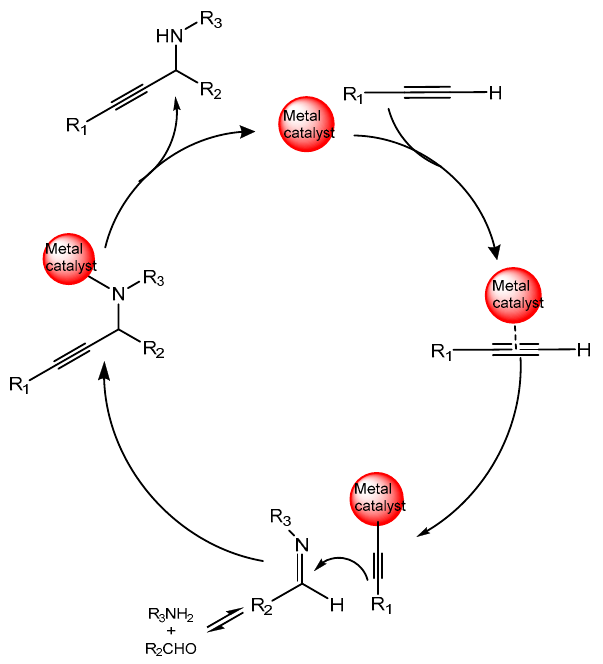
Figure 7. Plausible reaction mechanism for A3 coupling reactions [99].